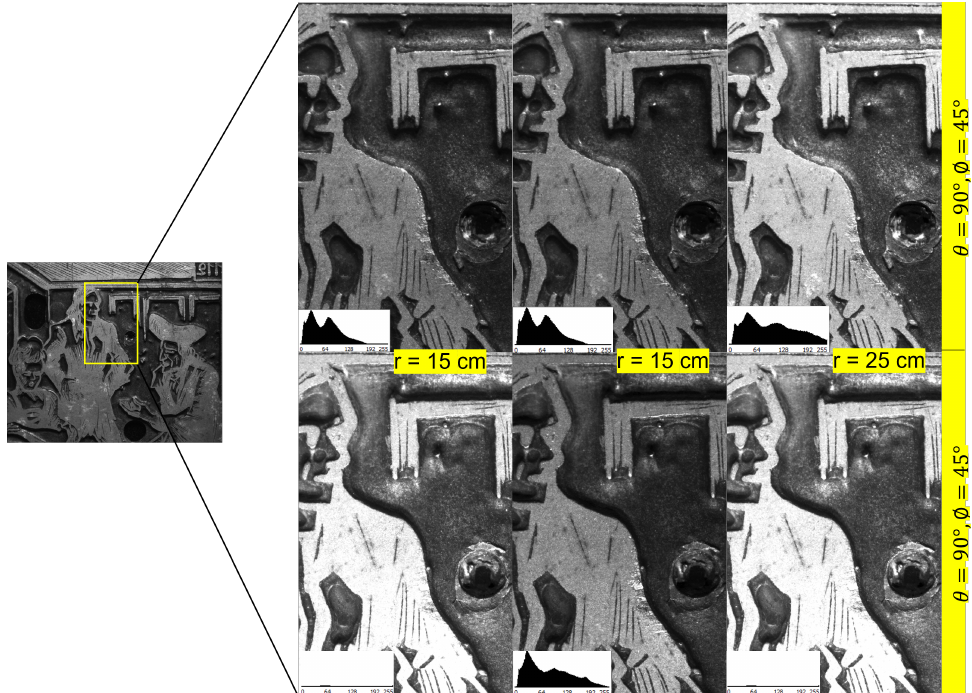
Figure 7. Relighting of the surface from RTI of the surface captured with dome of different sizes. In this example, the surface is relighted from θ = 90 ◦ , φ = 45 ◦ and from θ = − 90 ◦ , φ = 45 ◦